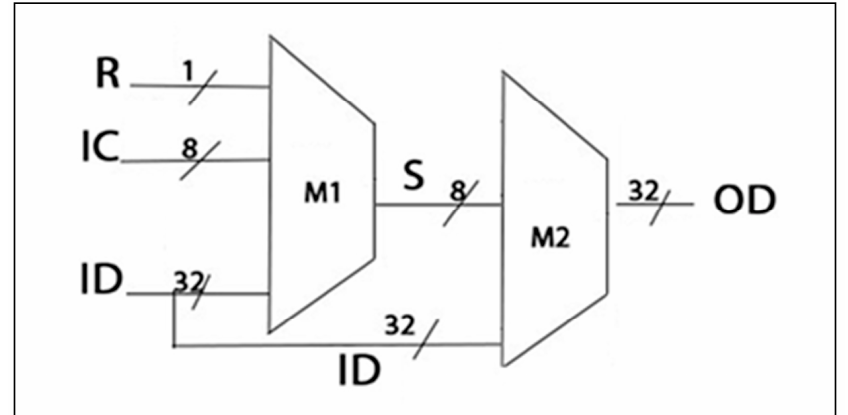
Figure 11. Circuit diagram c499 [34].